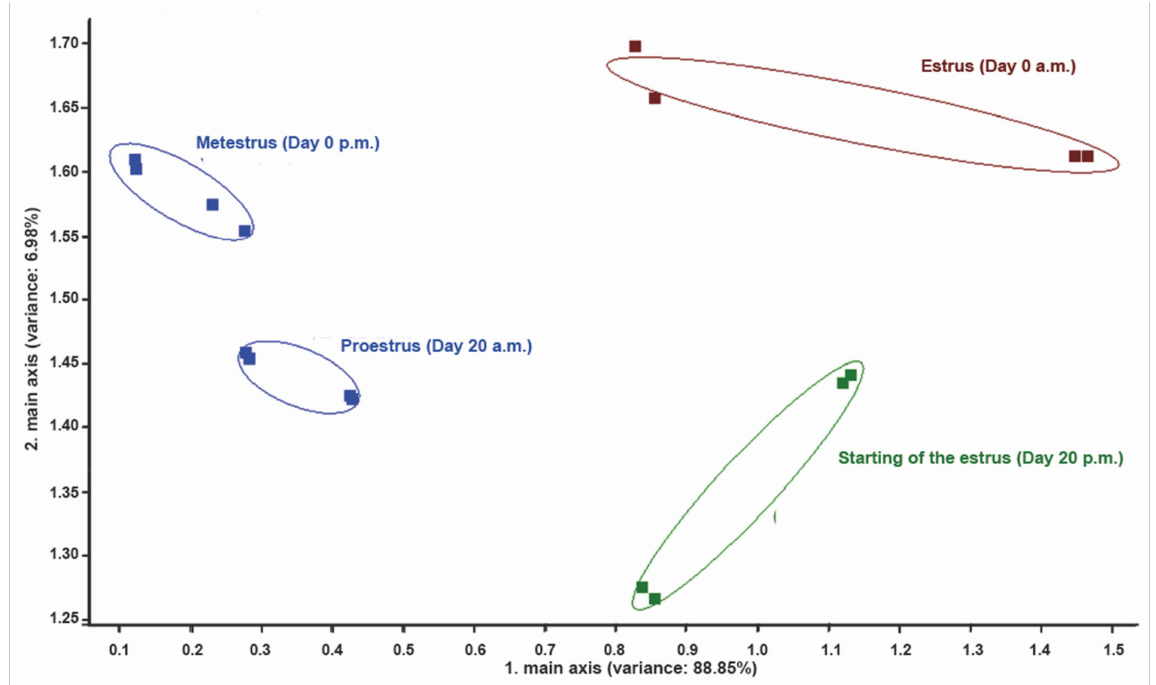
Figure 5. PCA of perineal headspace samples measurements at different phases of the reproduc- tive cycle in a cow from group II. Note the low discrimination between proestrus (day 20 a.m.) and metestrus (from day 0 p.m.). Note the high discrimination between proestrus (day 20 a.m.), beginning of estrus (day 20 p.m.) and most intensive estrus (day 0 a.m.), and between beginning of estrus (day 20 p.m.), most intensive estrus (day 0 a.m.) and metestrus (from day 0 p.m.). Num- bers in parentheses indicate percentages of the data matrix described by the relevant components and